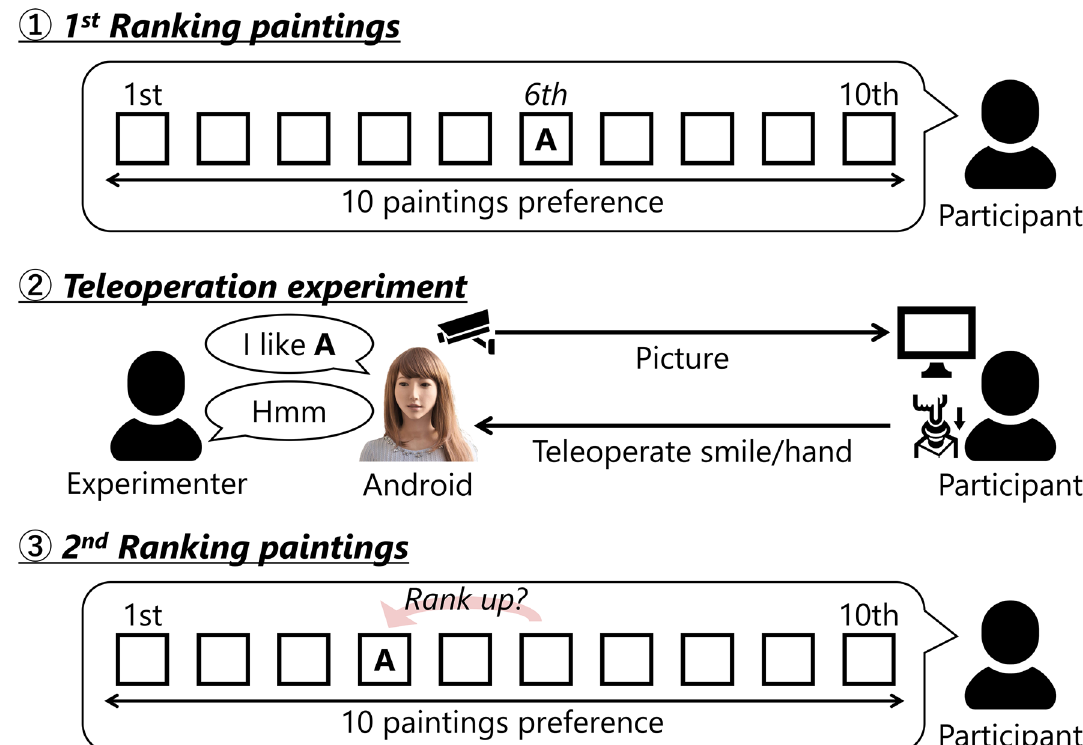
Figure 3. Outline of the experiment: (1) the participants were asked to rank the 10 given paintings. (2) They joined one of the three experimental conditions (SC, HC, and WC). In all conditions, the android recommended the painting that was ranked 6th by the participants to a male experimenter (he was assumed to be another participant by the participants). (3) Fifteen minutes after the experiment, the participants were asked to re-rank the same 10 paintings. If the rank of the painting recommended by the android was higher than that of the first painting, we can argue through this experiment that the attitude of participants is similar to that of the android, thus supporting our hypothesis.